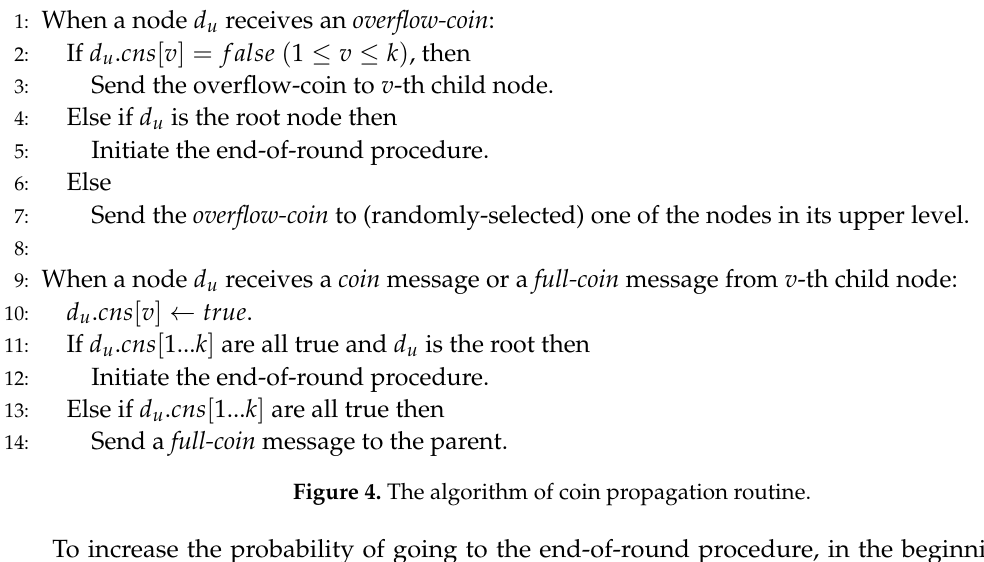
Figure 4. The algorithm of coin propagation routine.